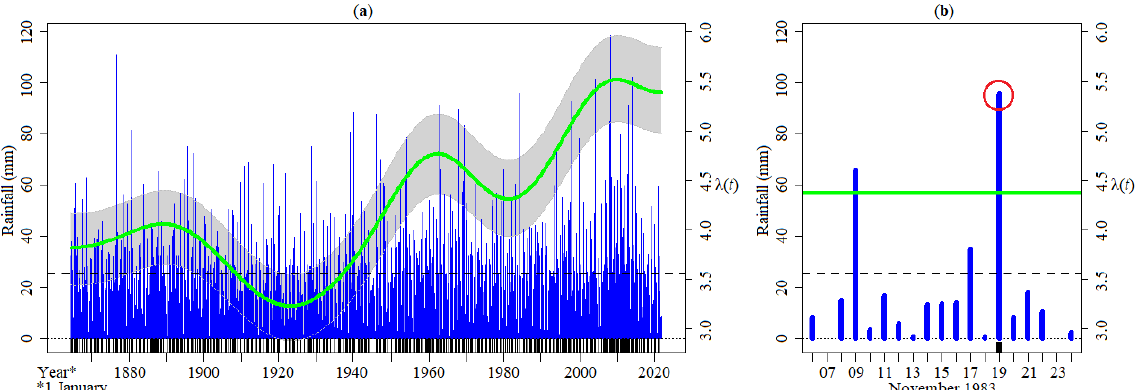
Figure 6. Peaks-over-threshold (POT) of daily rainfall from 1 October 1864 to 30 September 2021: ( a ) daily rainfall series (in blue), selected threshold a of 25 mm (horizontal dashed line), occurrence rate of POT per year, λ ( t ) (in green), and confidence band (grey area); ( b ) detail in the period from 6 to 24 November 1983 with the select peak circled in red (the confidence band is omitted). The vertical ticks represent the time data of the